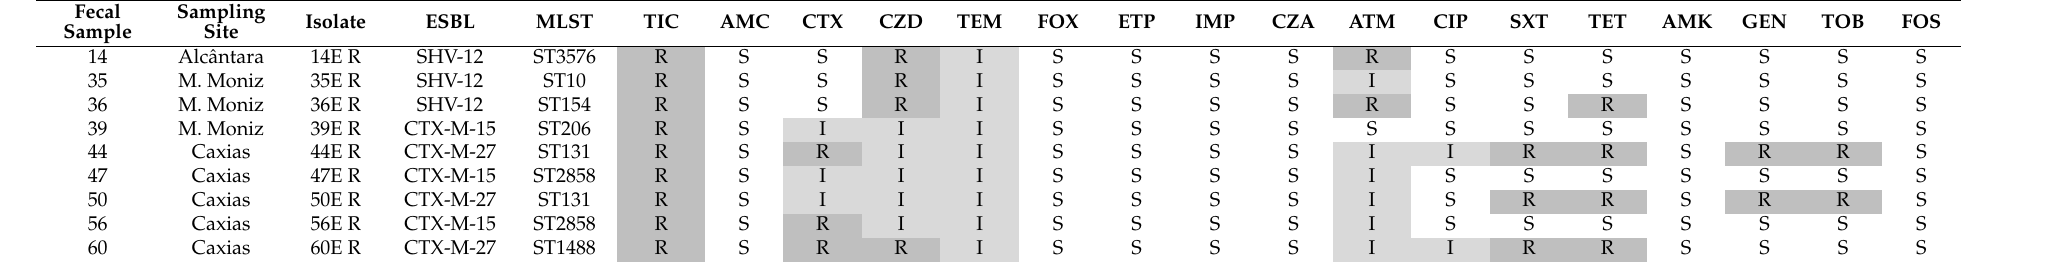
Table 2. Characteristics of the nine ESBL-producing E. coli